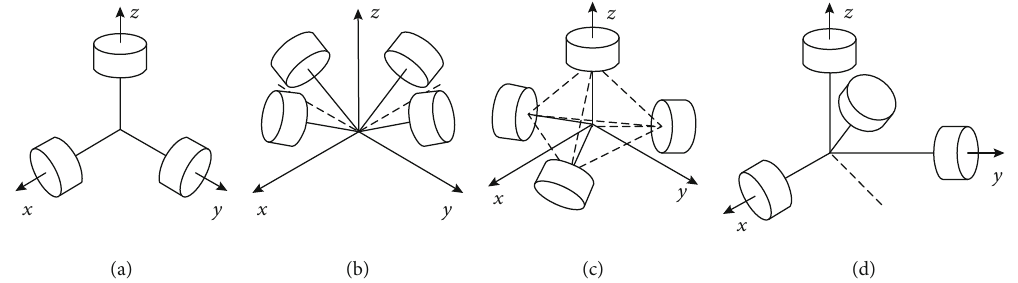
Figure 5: Reaction wheel con fi gurations: (a) orthogonal, (b) pyramidal, (c) tetrahedral, and (d) skew. Three con fi gurations of reaction wheels: orthogonal,